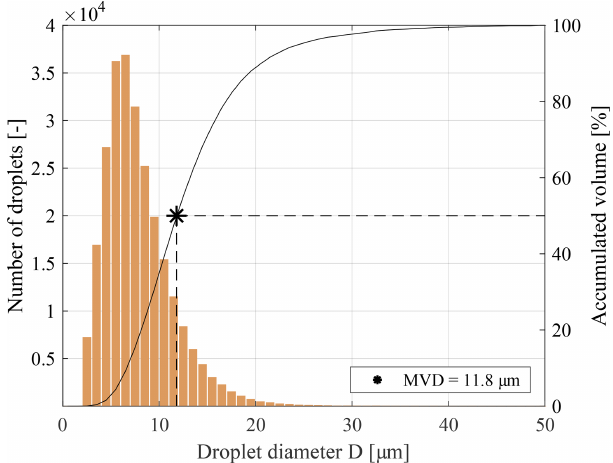
Figure 2. Droplet velocity over diameter (PDI run 8 August 2017 16:25LT).